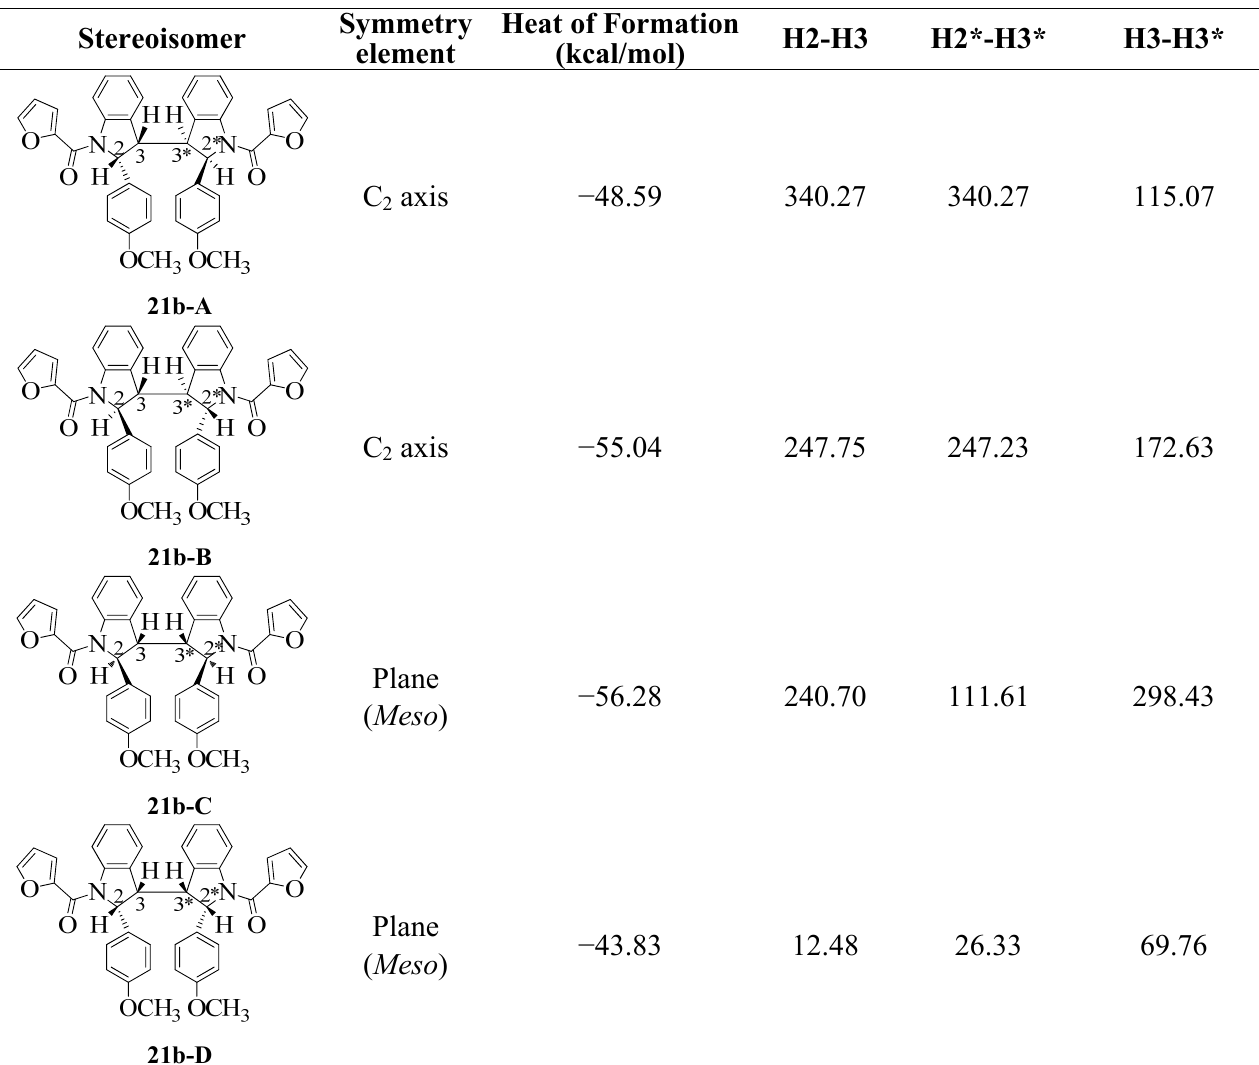
Table 5. PM6 calculation for 21b